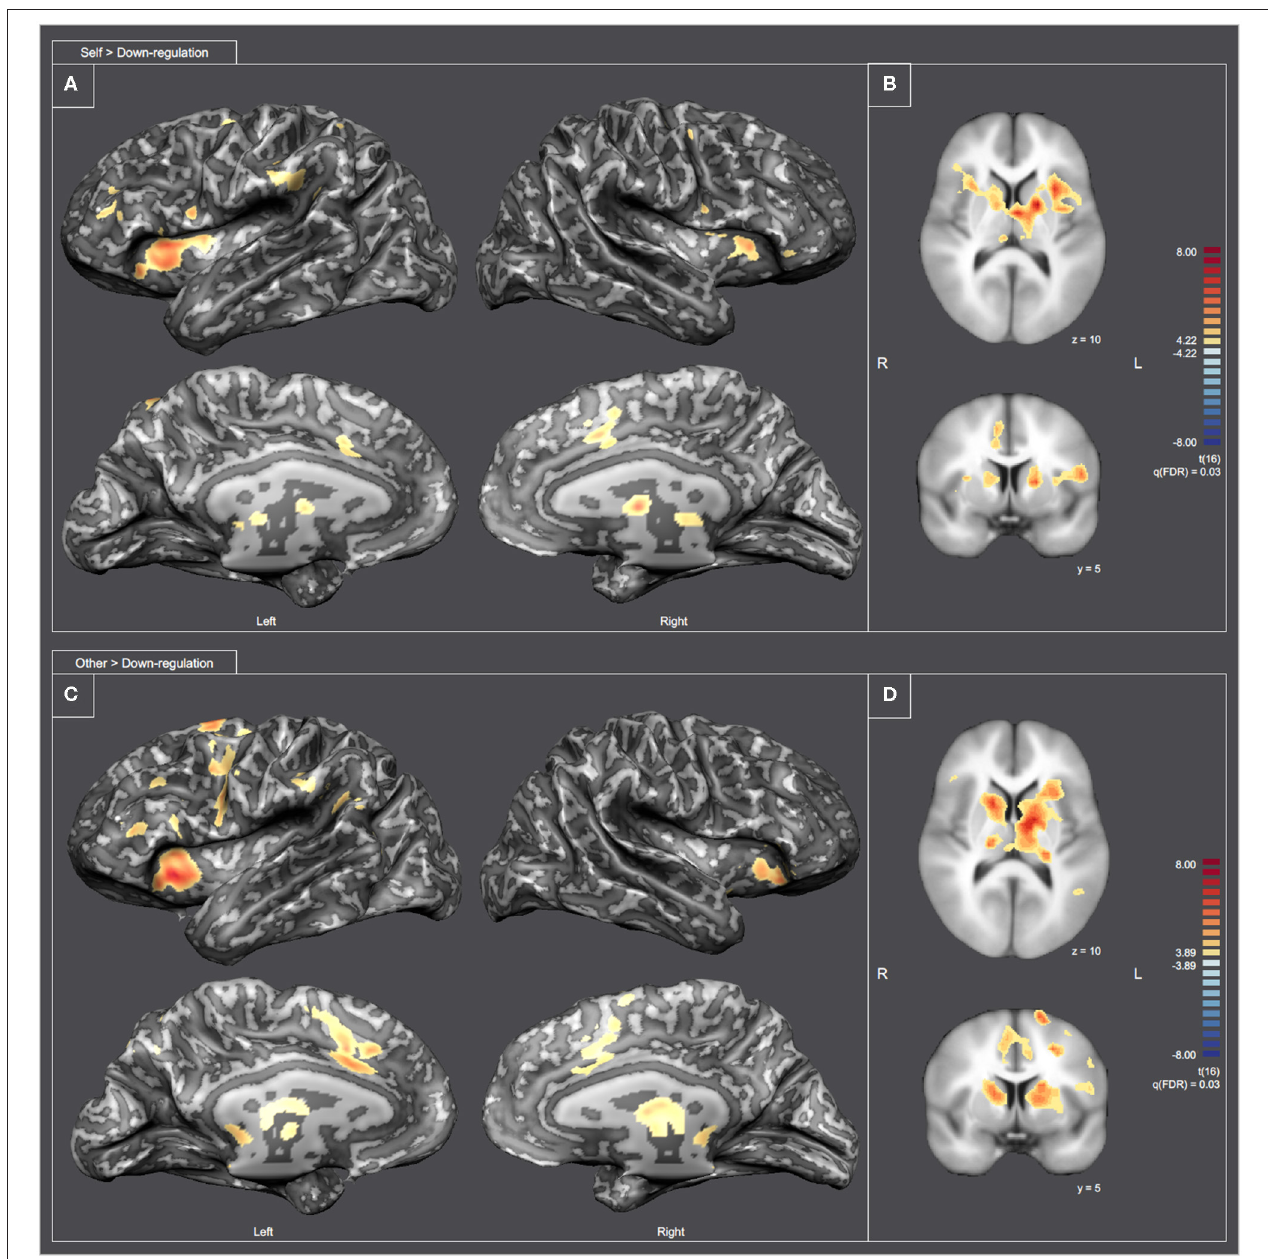
FIGURE 9 | Statistical map representation for the imagery runs [RFX-GLM, q(FDR) = 0.03]. (A,C) Display inflated cortex representations for the contrasts Self > Down-regulation and Other > Down-regulation, respectively. (B,D) Display subcortical activations projected in axial (Z = 10) and coronal (Y = 5) slices for the contrasts Self > Down-regulation and Other > Down-regulation,